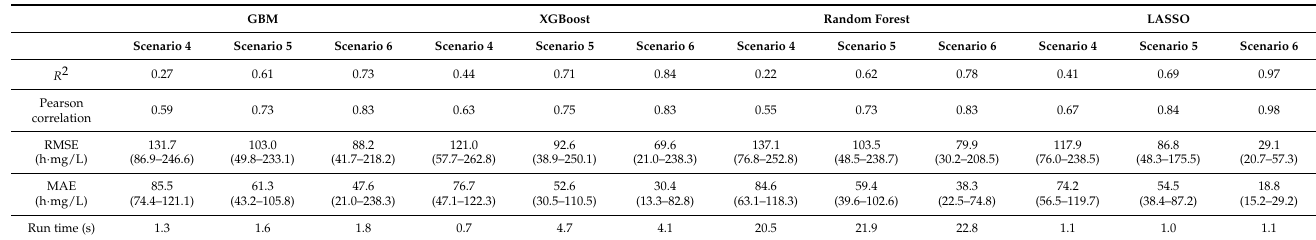
Table 4. Model performance for prediction of rifampicin AUC 0-24h using varying amounts of infor- mation as input.